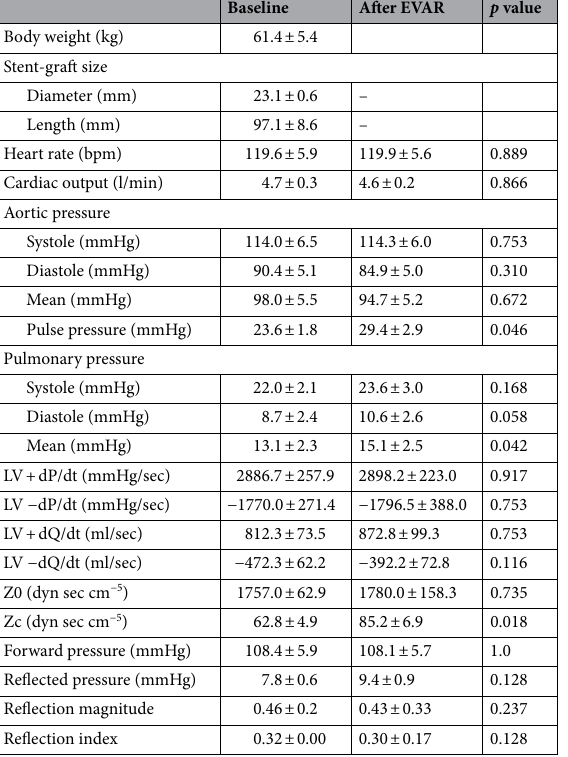
Table 1. Hemodynamic parameters at baseline and after stent-grafting. EVAR endovascular aortic repair, LV left ventricle, Value, mean ±